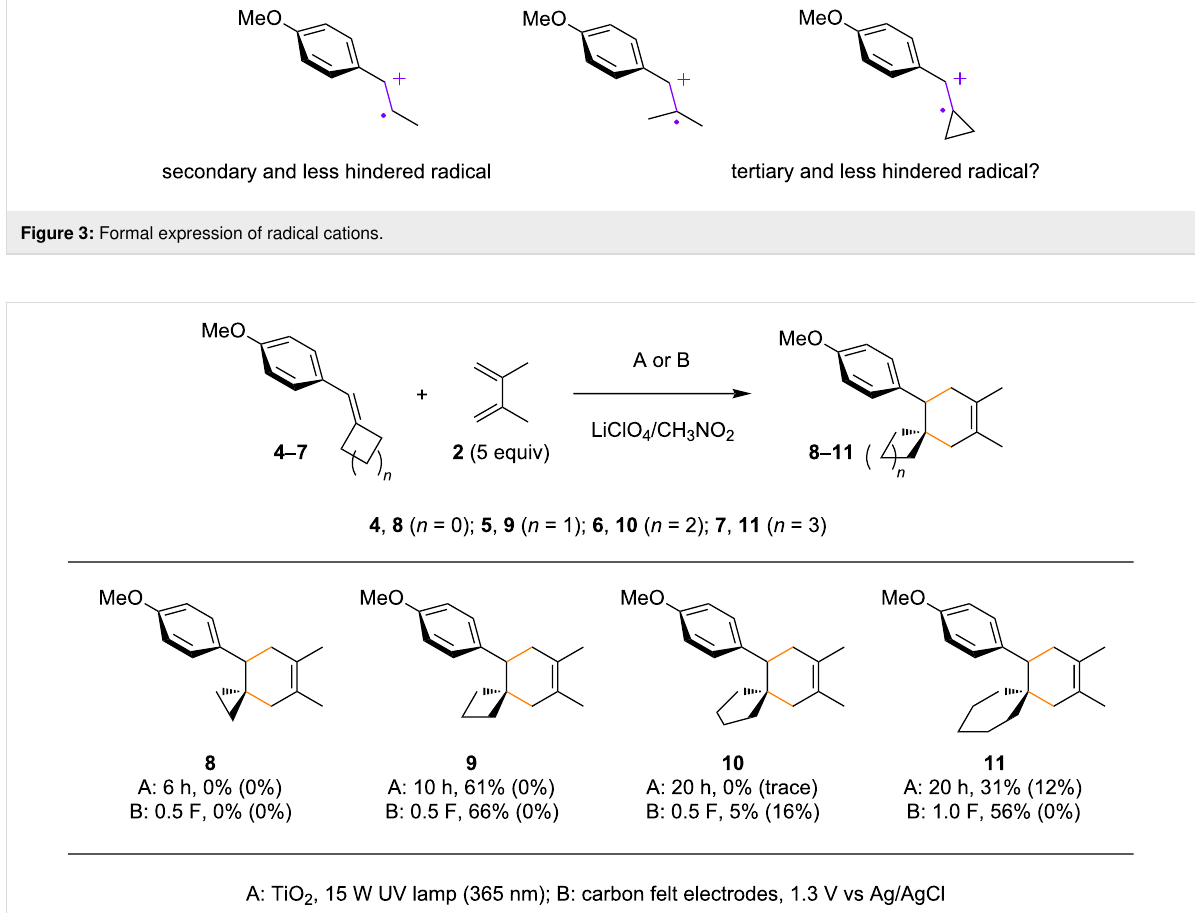
Scheme 3: Radical cation Diels–Alder reactions of the arylidene cycloalkanes ( 4 – 7 ). Recovered starting material is reported in parentheses.